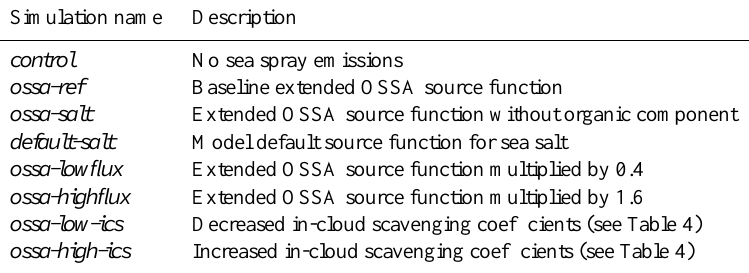
Table 3. List of simulations.